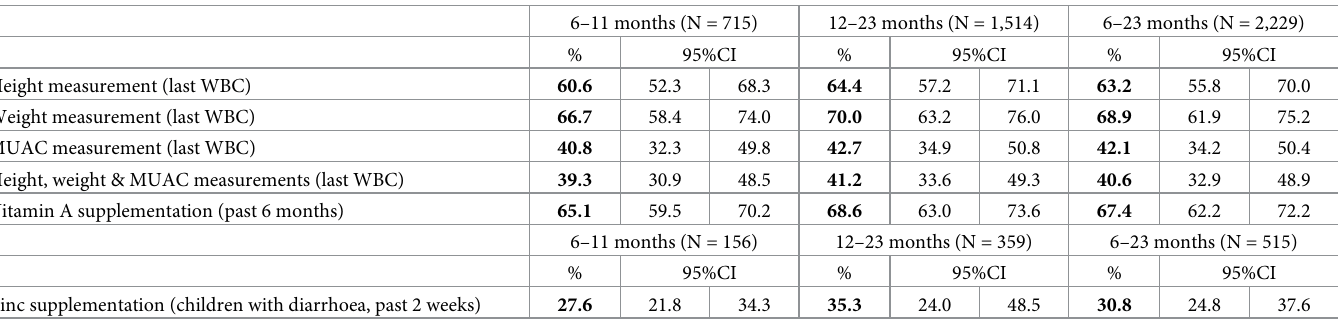
Table 2. Child growth monitoring, vitamin A and zinc supplementation per age group (6–11 and 12–23 months) and